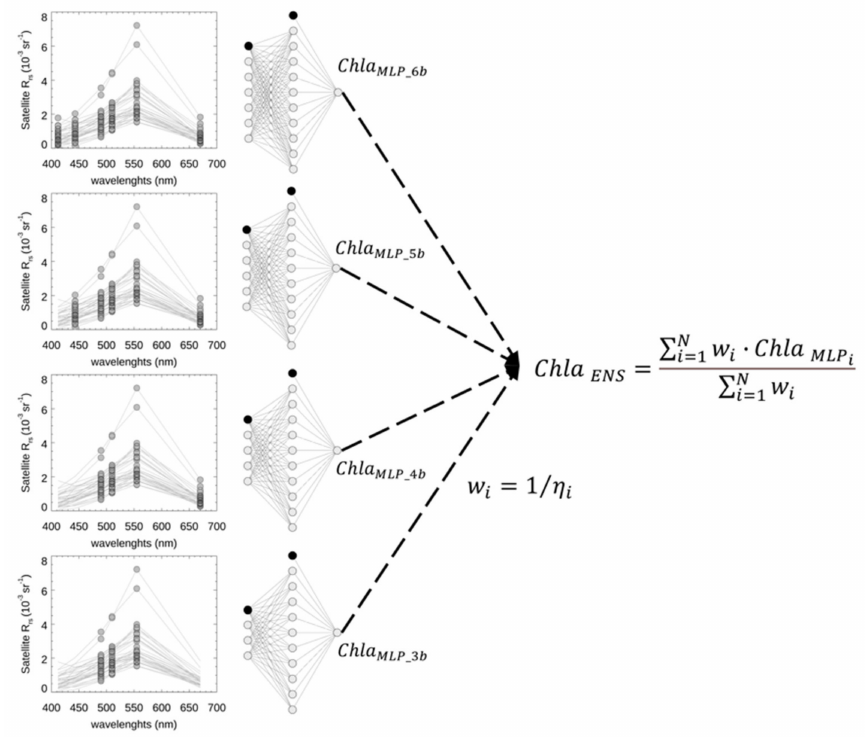
Figure 2. Ensemble scheme to determine Chl - a ENS by gathering the contribution of individual MLPs based on R rs at specific wavelengths through the corresponding novelty